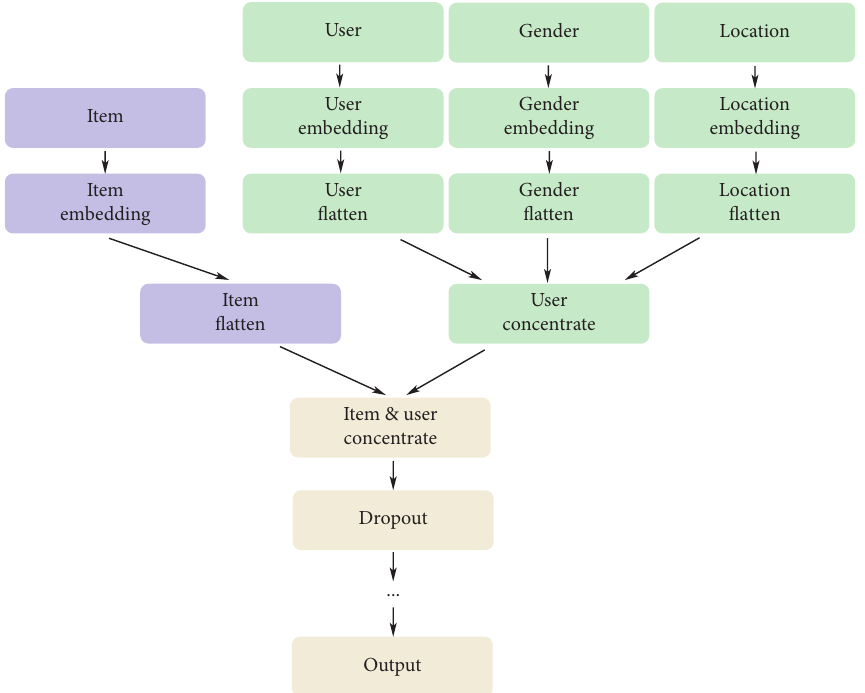
Figure 1: The architecture of the neural